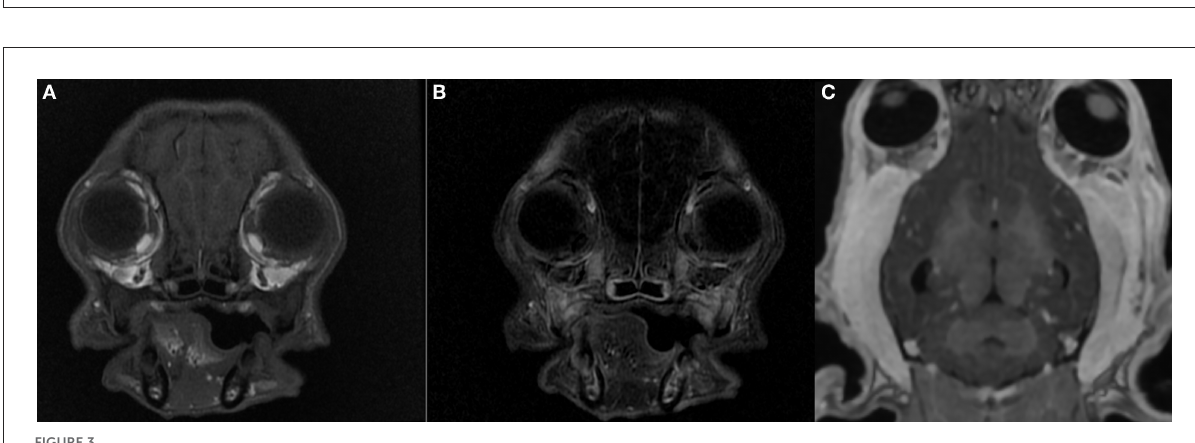
FIGURE3 Magnetic resonance imaging study of the head of a 5-month old Cavalier King Charles Spaniel affected by masticatory muscle myositis; pre-contrast T1-W image (A) , post-contrast T1-W subtraction image (B) , pre contrast 3D T1-W image (C) . Note the absence of extraocular muscle swelling and contrast enhancement; no evidence of